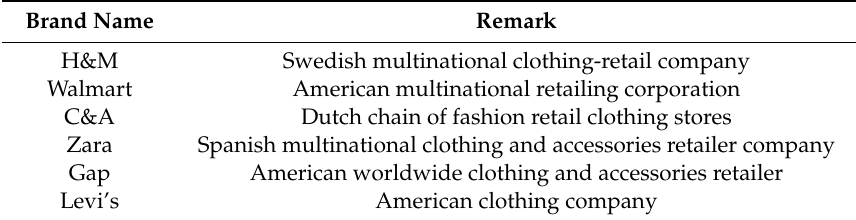
Table 2. Renowned retailers and brands that import from Bangladesh